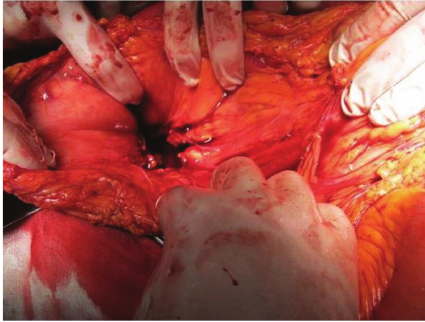
Figure 4: Intraoperative aspect: active pulsatile bleeding inside the cystic cavity.